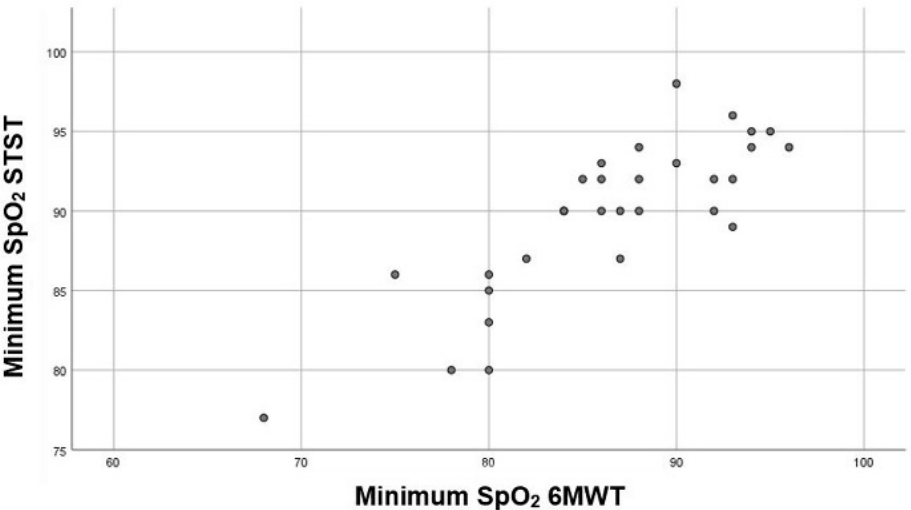
Figure 3. Correlation between minimum SpO 2 registered during the 1STST and the 6MWT. (SpO 2 = oxygen saturation; 1STST = 1-min sit-to-stand test; 6MWT = 6-min walking test).